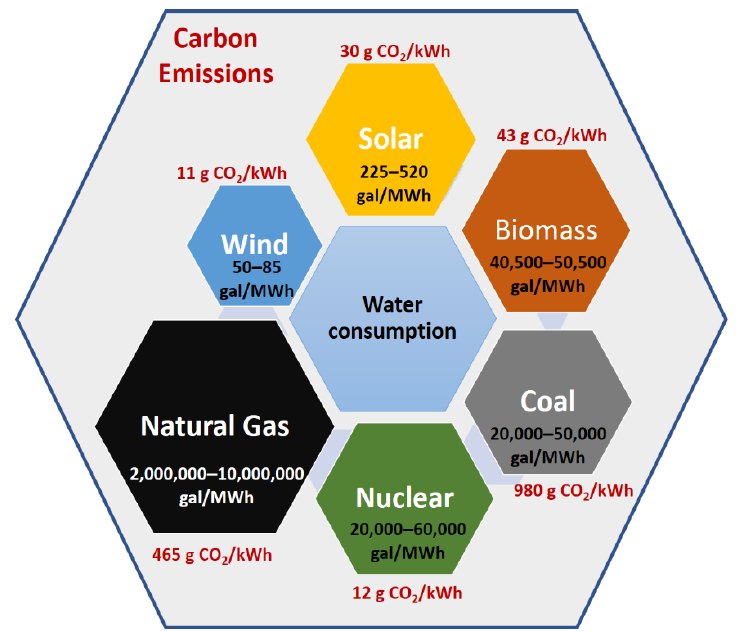
Figure 2. Water usage and carbon footprint of electricity generation sources